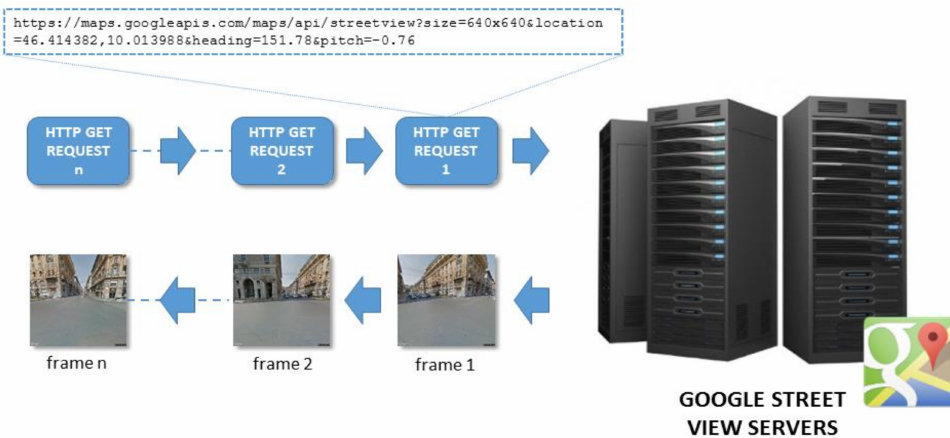
Figure 9. Logical architecture of the Image Geo-validation submodule. It identifies if an image is retrieved from a true location belongs to the monitored event.